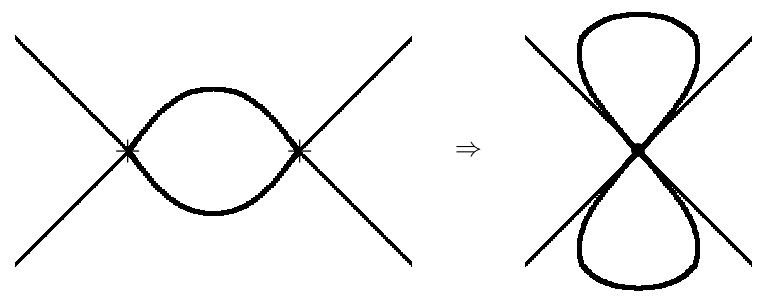
Figure 3 . Translating a Feynman diagram of the original open closed string field theory (left) into a Feynman diagram of the closed string effective field theory (right). The interaction vertices in the left diagram are D-instanton type interaction vertices of the open closed string field theory and the vertex labelled by • on the right diagram is a D-instanton type interaction vertex of the closed string effective field theory. The propagators displayed in this diagram are closed string propagators. If the original diagram had any open string propagator, it would have been fused into the interaction vertex of the effective field